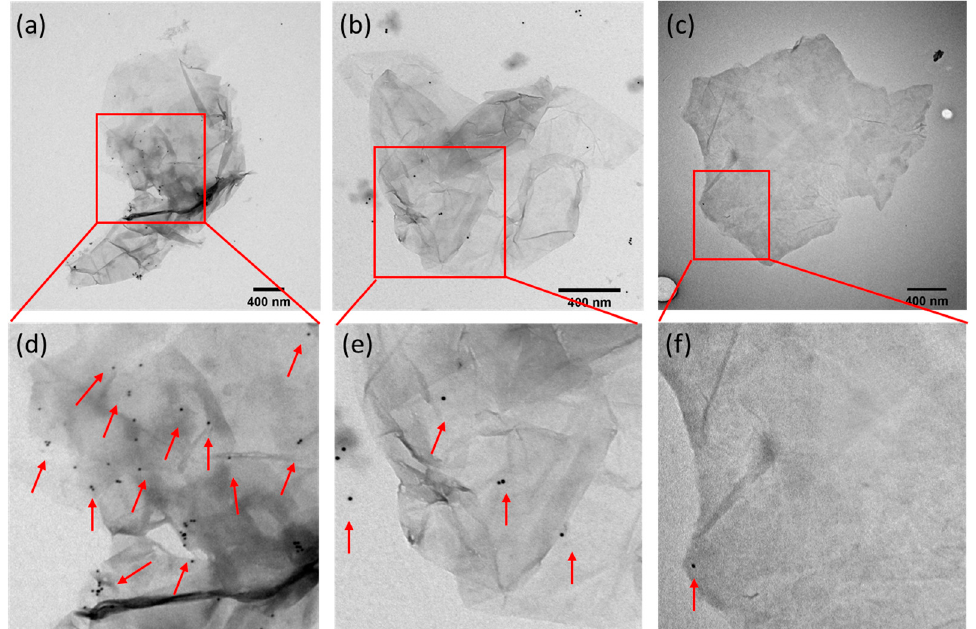
Figure 2. TEM images ( a – c ) and magnified images ( d ), 3 × magnification of ( a ); ( e ), 3 × magnification for ( b ); ( f ), 4 × magnification for ( c ) illustrating the immunostaining of ( a , d ) GO–FA, ( b , e ) GO–FA– CTR using an antiFA antibody and a secondary antibody and ( c , f ) GO–FA using the nonspecific antibody hRANK-M331 and a secondary antibody. The gold nanoparticles are pointed out with red